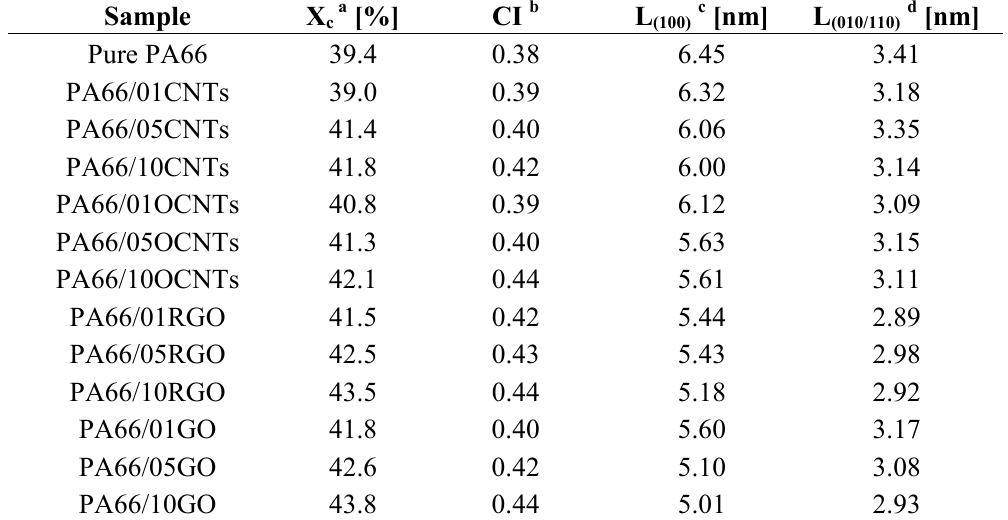
Table 4. Crystallisation properties of the electrospun